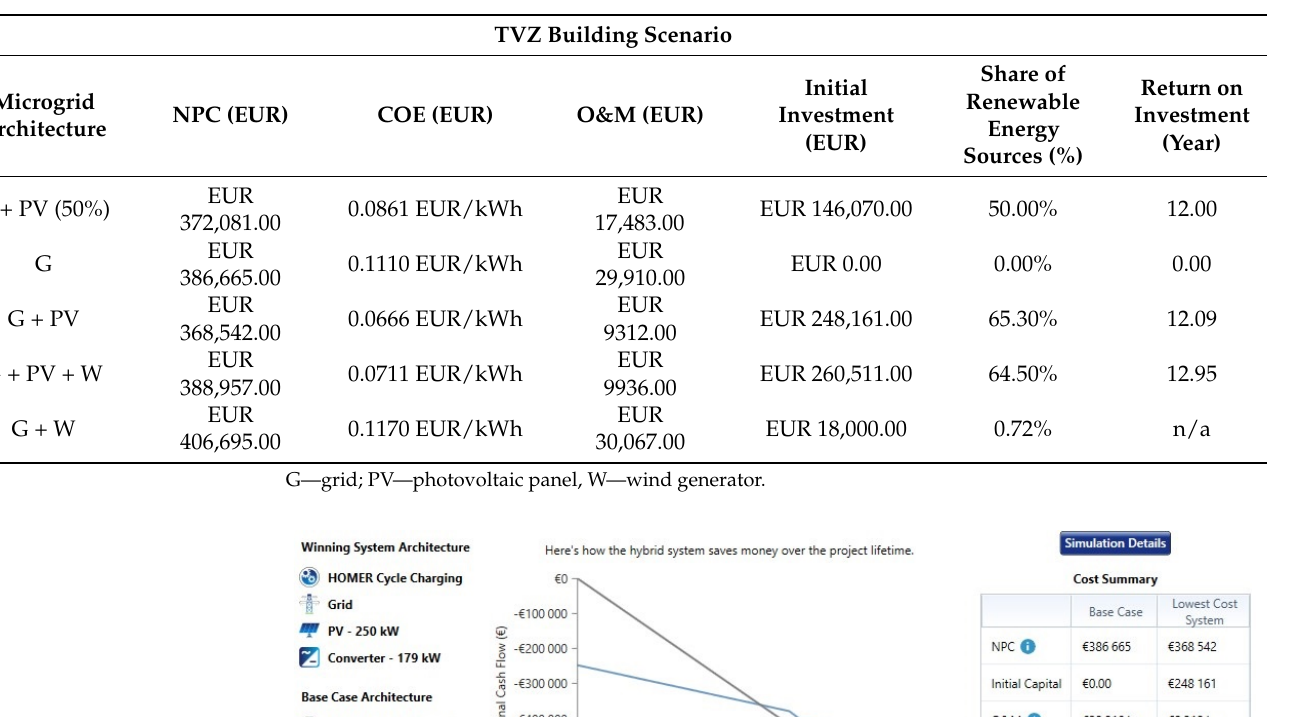
Table 6. Presentation of developed models in scenario of selected example of TVZ building.